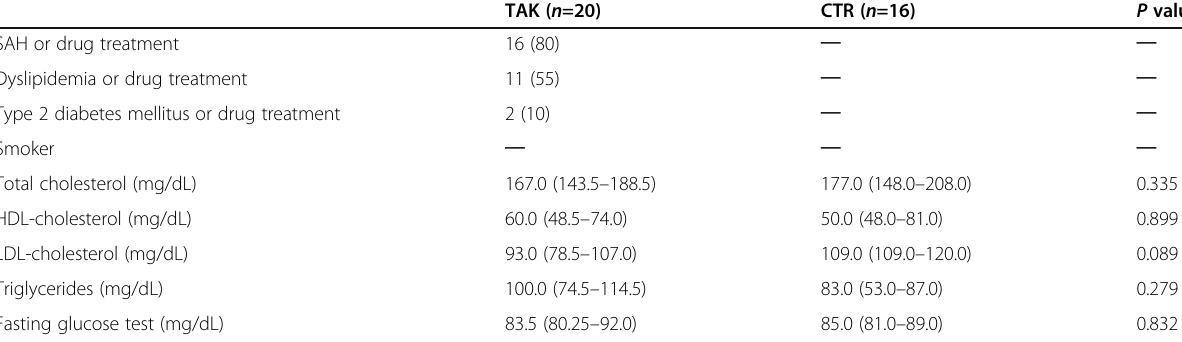
Table 2 Comorbidities and traditional risk factors for cardiovascular diseases